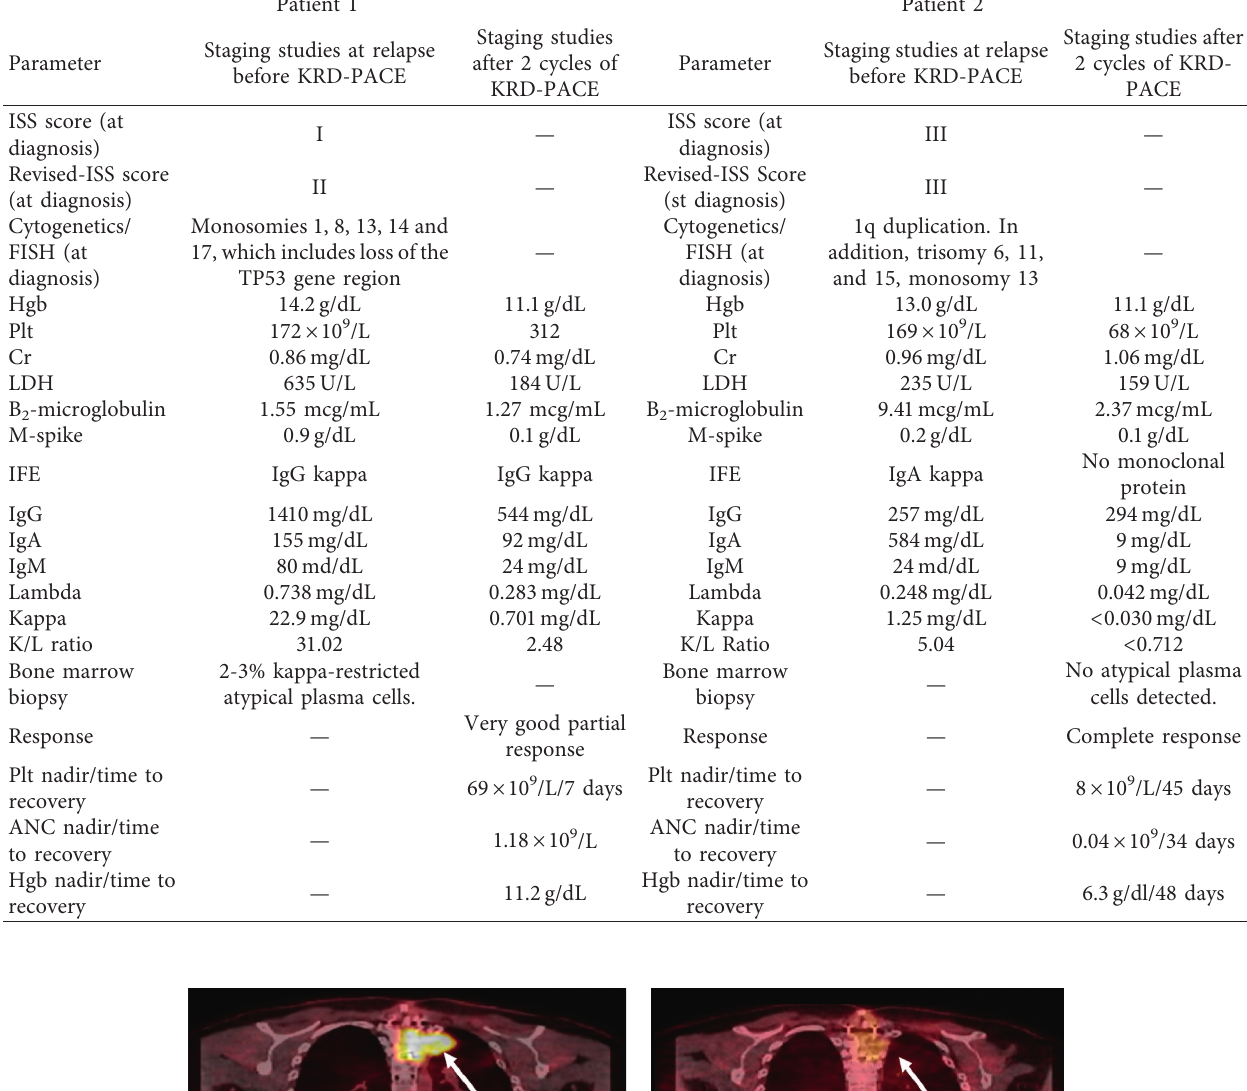
Table 1: Response measurement and hematologic toxicity/recovery time after 2 cycles of